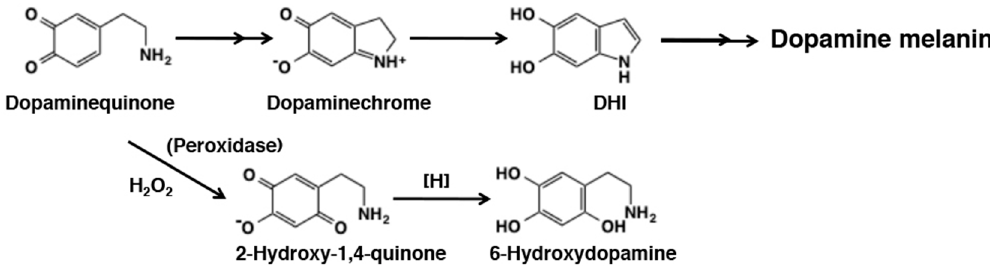
Figure 31. Reaction of dopaminequinone leading to the production of dopamine melanin through dopaminechrome [129,179]. Note that oxidation of dopamine with peroxidase/H 2 O 2 gives 6- hydroxydopamine after reduction [67].